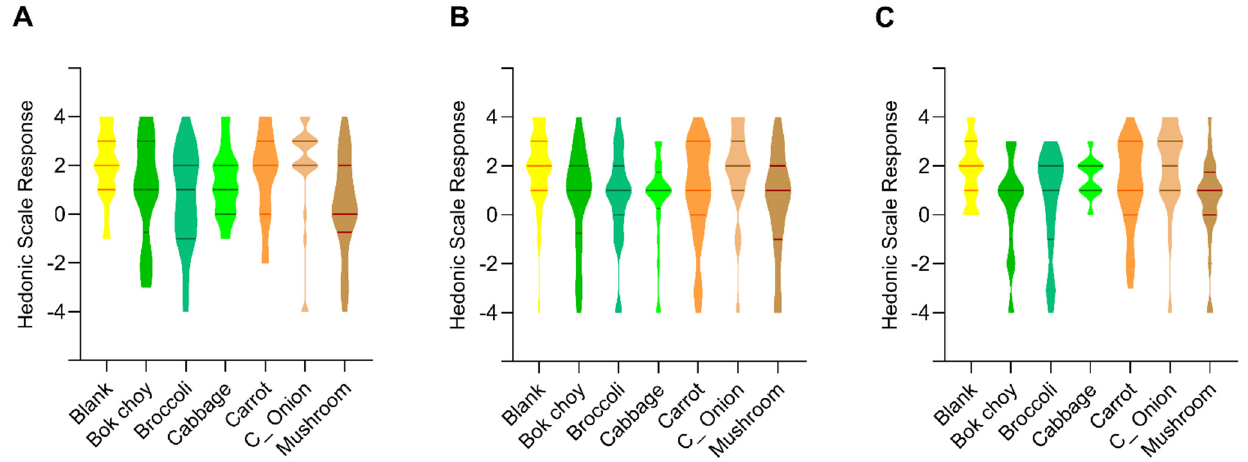
Figure 5. Tasting sensory evaluation of differently fortified ugali . ( A ) violin plot of the sensory evaluation of taste of differently fortified ugali ; ( B ) violin plot of the sensory evaluation of granularity of differently fortified ugali . ( C ) violin plot of the sensory evaluation of viscosity of differently fortified ugali . The x -axis title indicates the vegetable powder added in corresponding ugali , and lines in each violin plot are the upper quartile, median, and lower quartile line, respectively.